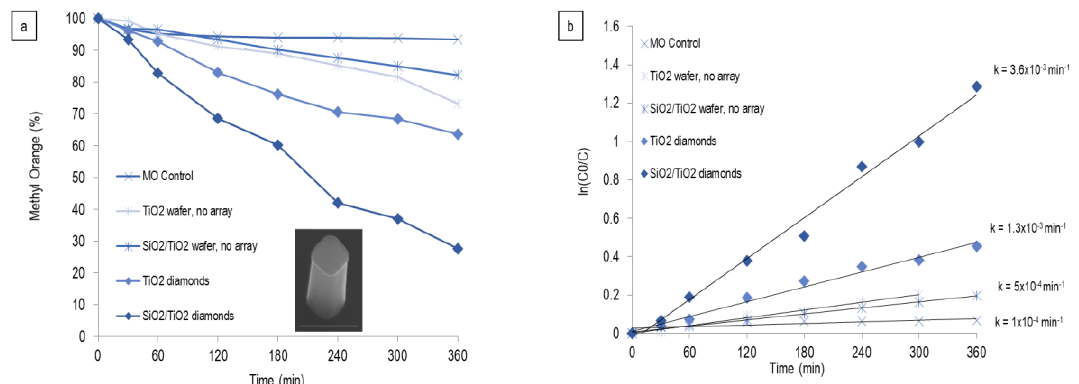
Figure 8. Photocatalytic response of TiO 2 and SiO 2 -TiO 2 -coated rhombic prism (diamond) post array; ( a ) percentage of methyl orange degradation over time upon exposure to UV light of SiO 2 -TiO 2 -coated rhombic prism (diamond) post array, inset showing an SEM structure—scale 500 µ m; ( b ) rate of reaction of methyl orange degradation over time upon exposure to UV light of SiO 2 -TiO 2 -coated rhombic prism (diamond) post array.